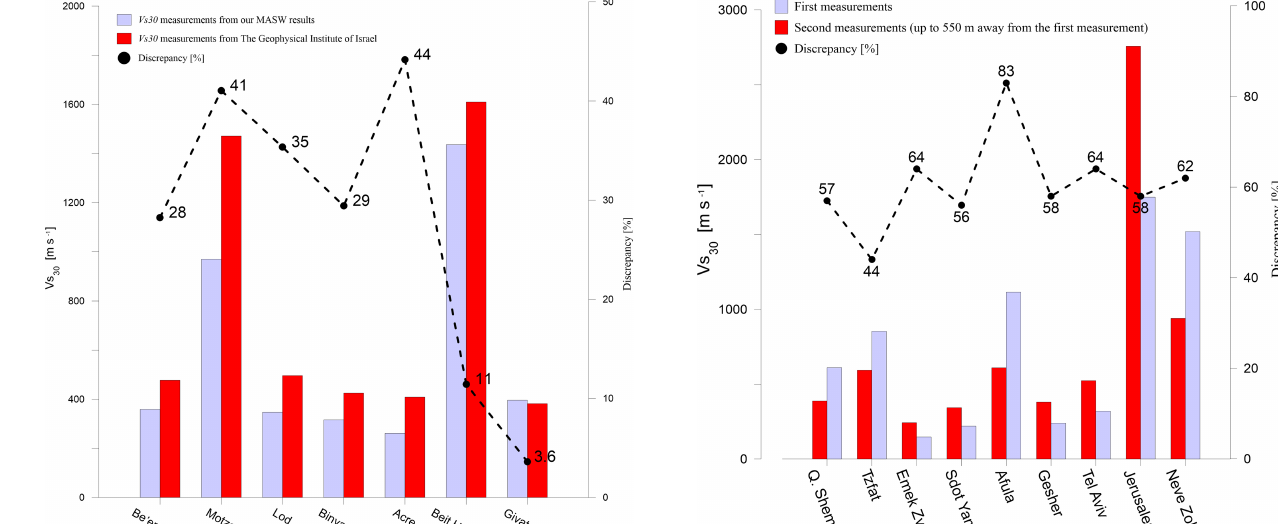
Figure 10. Comparison between GII’s closest measurements (up to